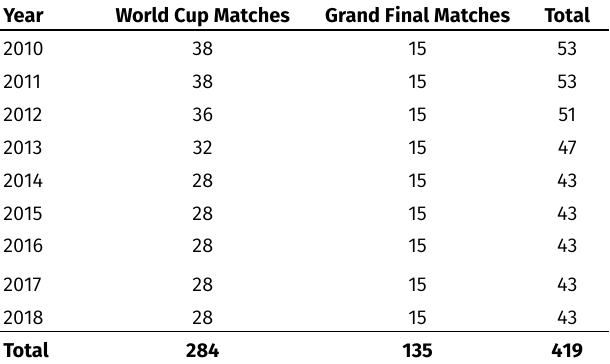
Table 1. Data set overview. In total there are 419 matches that have been used of which the majority is coming from the World Cups.